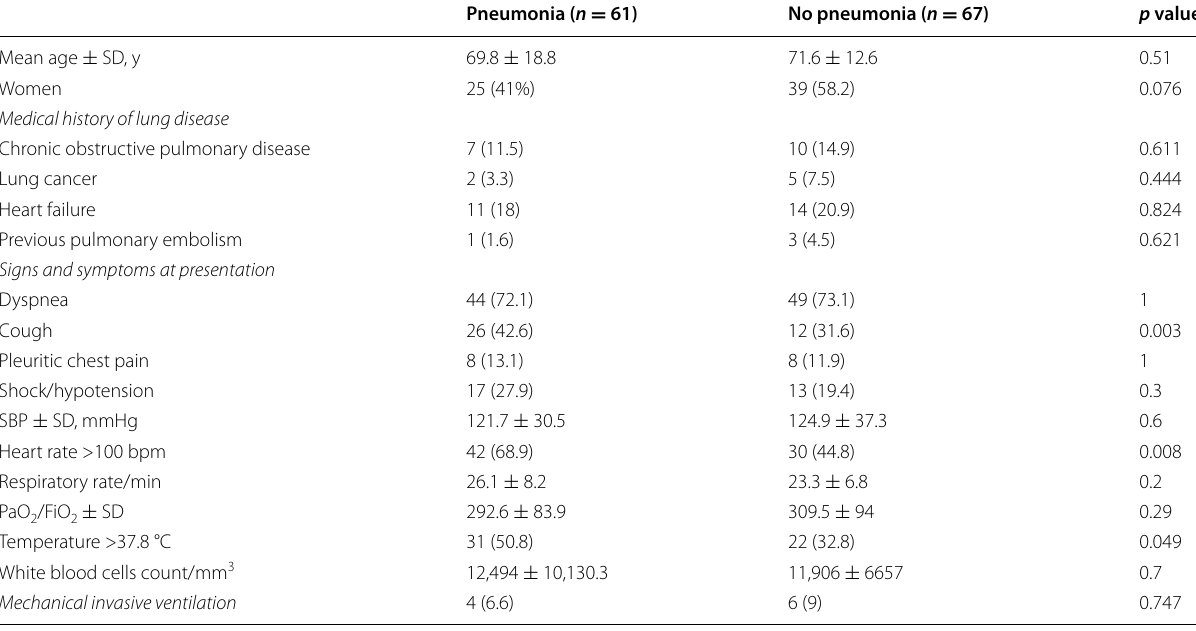
Data are given as no. (%) or mean